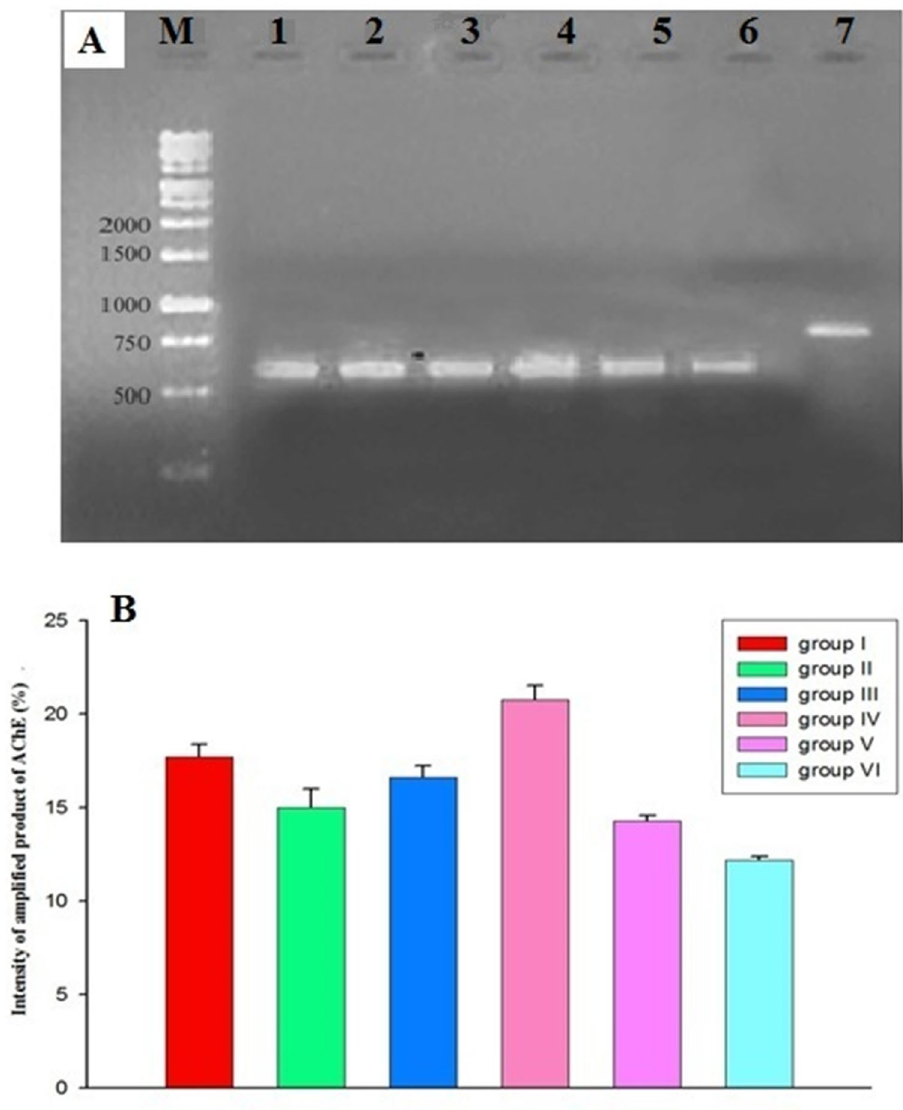
Figure 6. (A,B) Products of expression of site specific amplification of AChE gene with primer 3 and change in their intensity pattern in different groups. M—marker, Lane 1—group I, Lane 2—group II, Lane 3—group